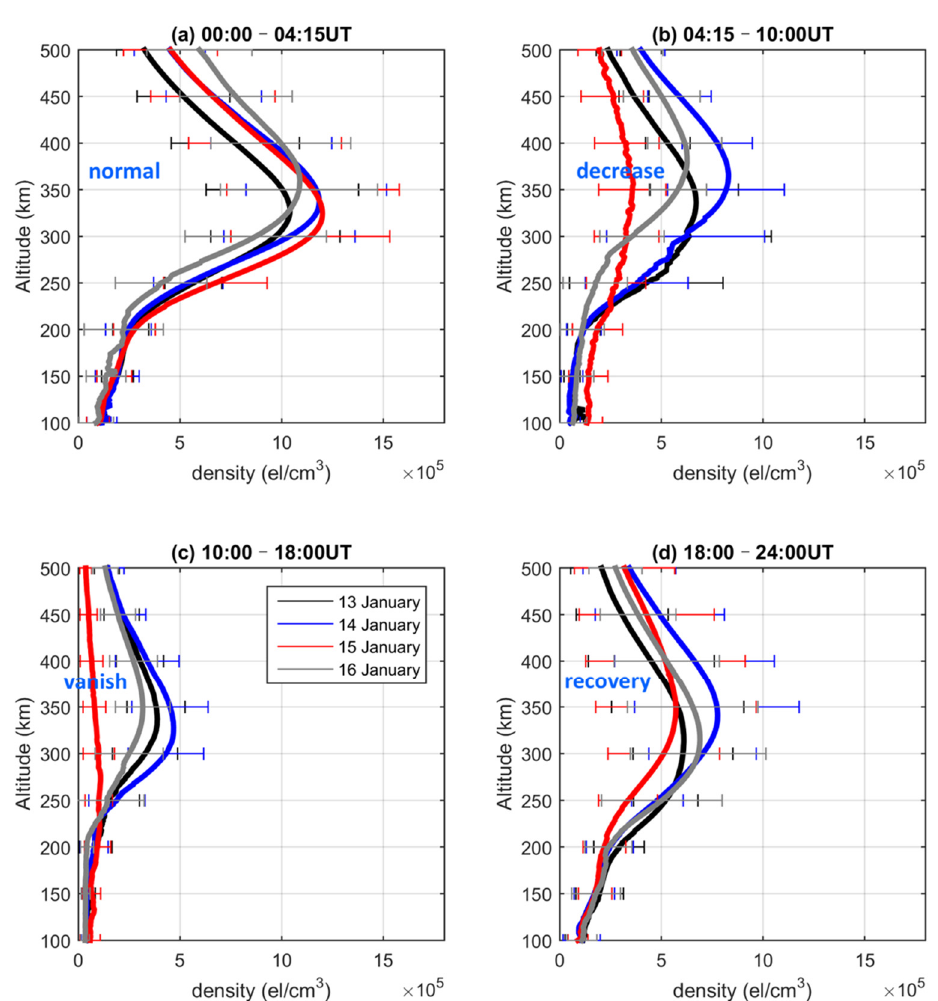
Figure 3. Comparison of the mean Ne profiles ( a ) before and ( b – d ) after the eruption on 15 January and those on the two days before (13 and 14 January) and the one day after (16 January). The error bar is the standard deviation of the Ne values at each altitude. The F 2 layer vanished almost during the period between 10:00–18:00 UT.